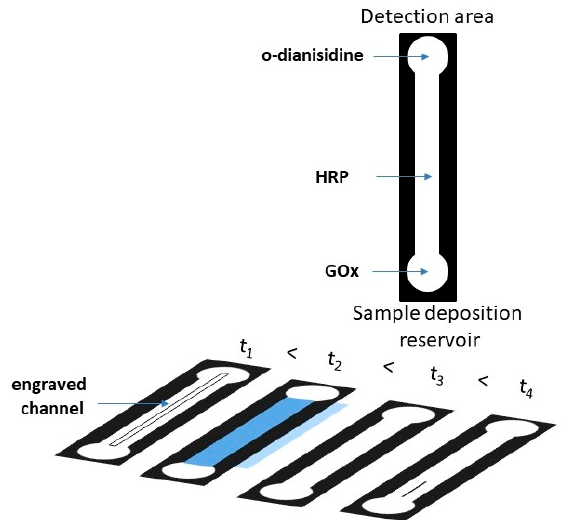
Figure 2. Top view of paper channels incorporating various fluidic delays and accelerators for performing a kinetic glucose enzymatic assay.